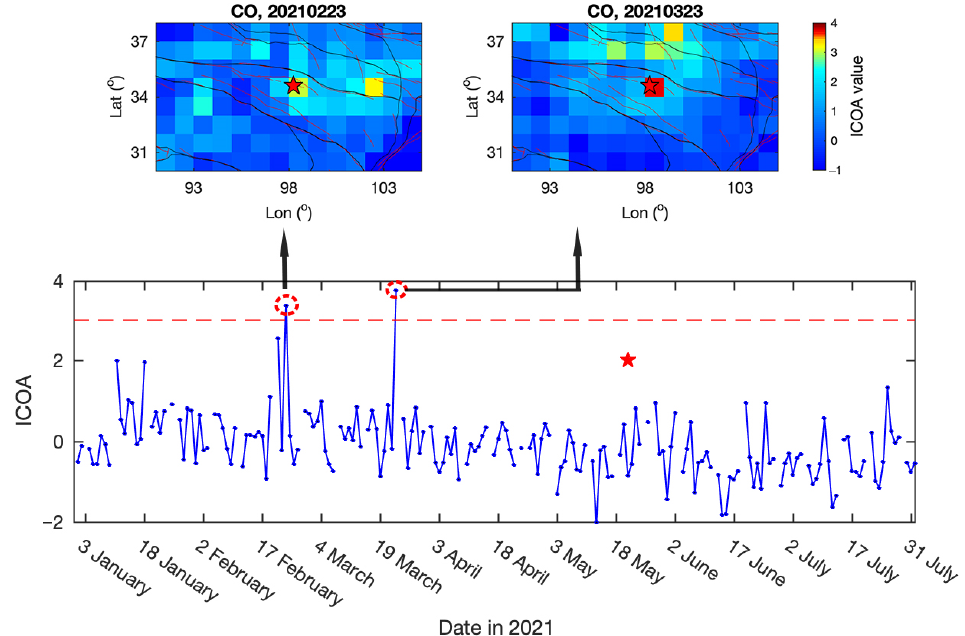
Figure 9. Spatial-temporal variation in the ICOA associated with the Madoi M 7.3 earthquake. The red dashed line indicates the threshold line with ICOA = 3. The red circles indicate the values exceeding the threshold line.